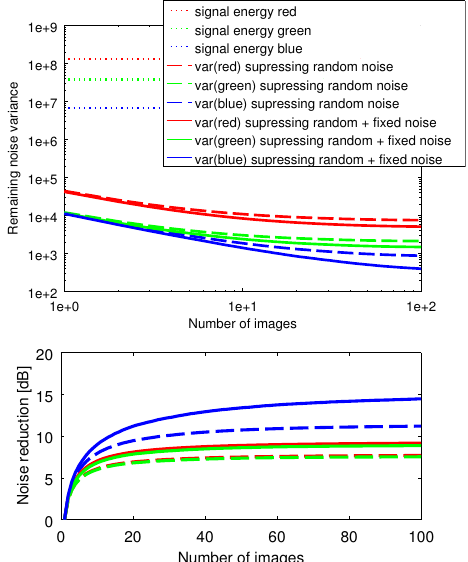
Figure 6. Noise reduction of the proposed approach with and without FPN for increasing numbers of images within the differ- ent color channels (denoted in corresponding color). Top: Re- maining noise variance in the 16-bit value range. Bottom: Noise reduction in dB relative to the initial